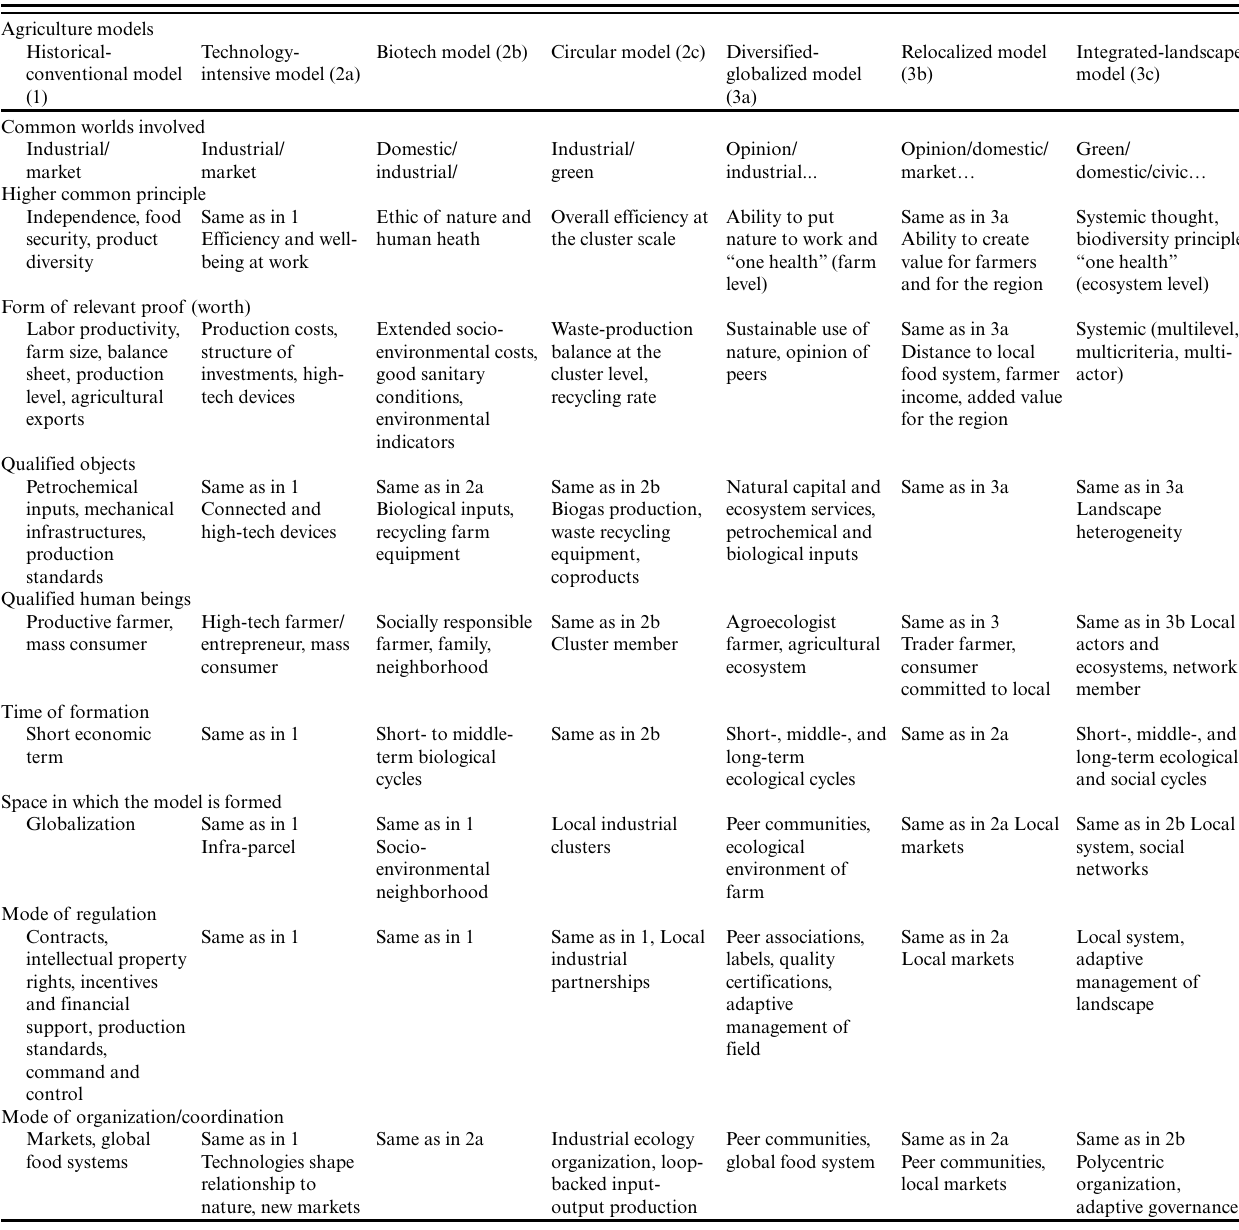
Table 1 . Institutional characterization of current Western sustainable agriculture models. Agriculture models